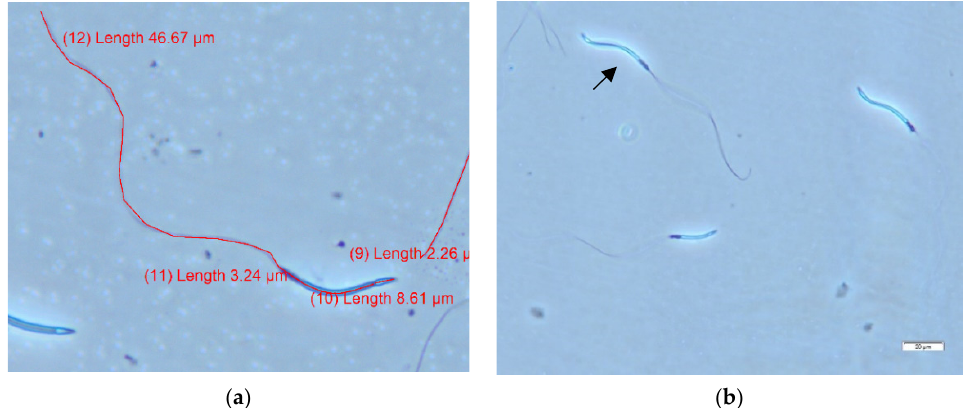
Figure 2. ( a ) Arabian bustard sperm measurements of the acrosome, head, midpiece and tail on cellSens image software, numbers between parentheses are generated by the software to count segments, and the length is represented in micrometers (version 1.12, Olympus cellSens Software); ( b ) Arabian bustard sperm showing a teratogenic defect (double-tail, highlighted by the arrow) and differences in sizes (Hancock solution fixation, wet chamber method, phase contrast 1000× oil, Olympus BX41).